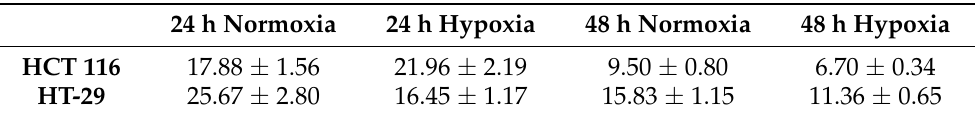
Table 1. SKR concentration resulting in a 25% decrease of metabolic activity based on MTT assay for cancer cell lines. Values are presented as concentrations in µM with standard deviation (SD) values for all used times and